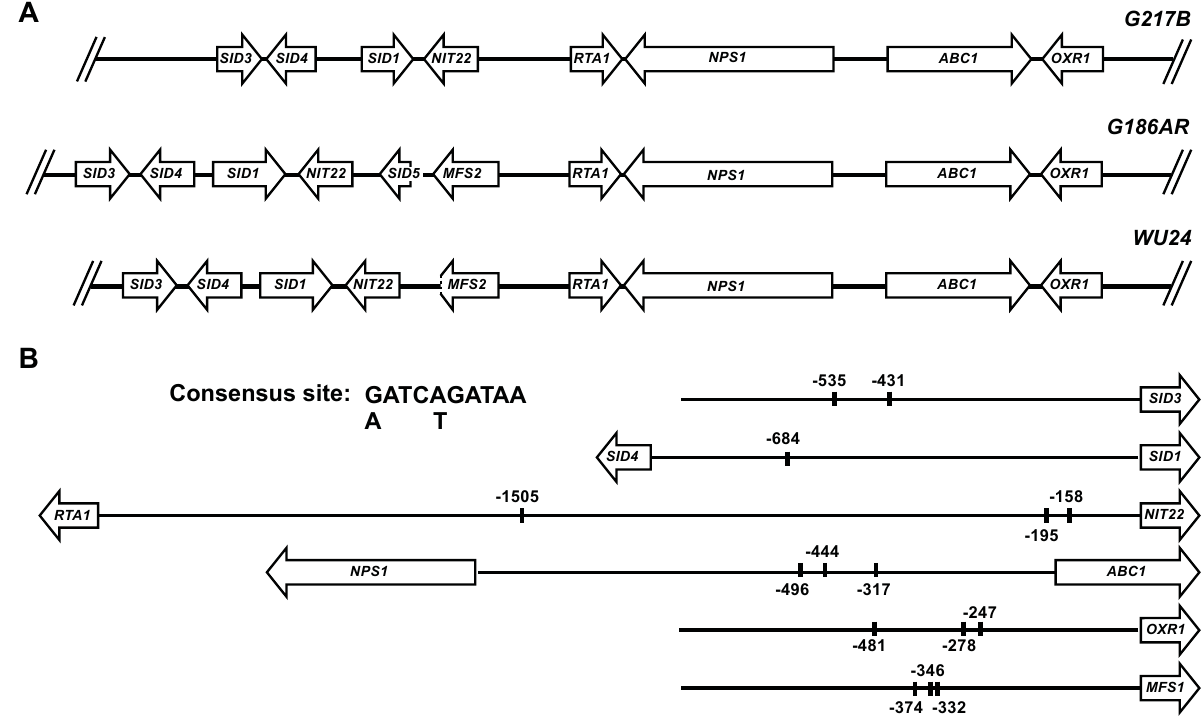
Figure 2. Genome Organization and Consensus Site Identification for Siderophore Biosynthetic Genes. A. Schematic showing genome structure of siderophore biosynthesis and utilization genes in H. capsulatum strains G217B, G186AR, and WU24. B. Location and sequence of putative consensus site in promoters of siderophore genes in the G217B strain. One kilobase of sequence 5 9 to the open reading frame for each gene is represented by a black line, except for the divergent genes: SID4 and SID1 , with an intergenic region of 1036 bases; RTA1 and NIT22, with an intergenic region of 2762 bases; and NPS1 and ABC1 , with an intergenic region of 1677 bases. The location of the consensus sequence is marked with a short vertical line and the associated number represents the number of base pairs from the start codon of the downstream gene. The 5 9 to 3 9 orientation of the consensus site is not indicated.